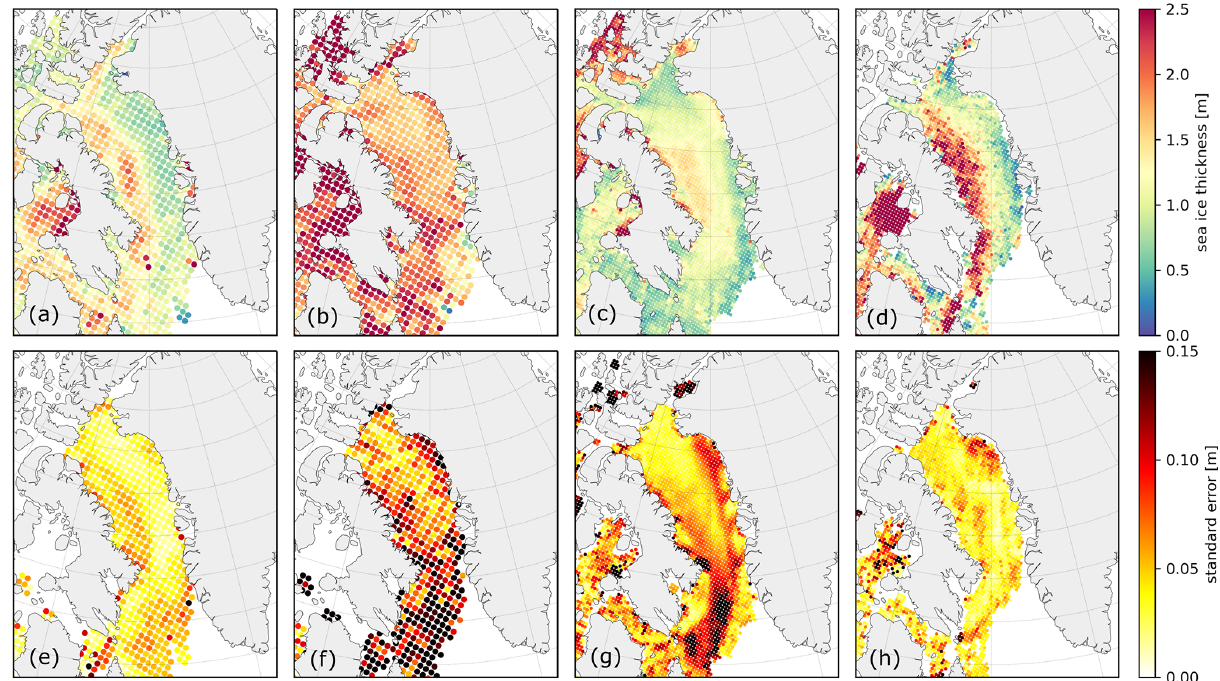
Figure 5. March mean sea ice thickness, mean, and standard error of mean of all processing methods for (a,e) ICESat (2003–2009), (b,f) En- visat (2003–2012), (c,g) CryoSat-2 LARM (2011–2020), and (d,h) ICESat-2 (2019–2020). Table 2. ICESat mean sea ice thickness (2003–2009) for different snow depth products and snow redistribution methods. The first values represent the W99 snow density values, and the italic values represent SnowModel-LG snow density product. W99 [m] PMW [m] SnowModel-LG [m] No redistribution 1.23 ± 0.45 1.03 ± 0.45 1.12 ± 0.44 1.18 ±